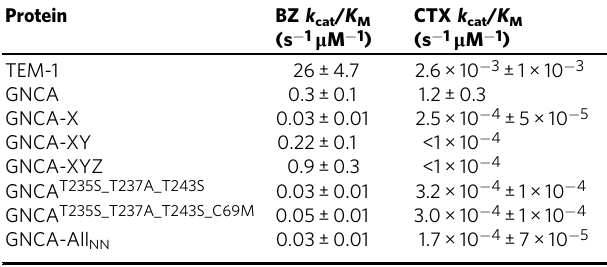
Table 1 Experimental characterization of wild-type β - lactamase GNCA and TEM-1 β -lactamase, and the mutants created by mutation sets X, Y, and Z by calculating their turnover rates for catalysis of antibiotics benzylpenicillin (BZ) and cefotaxime (CTX). Protein